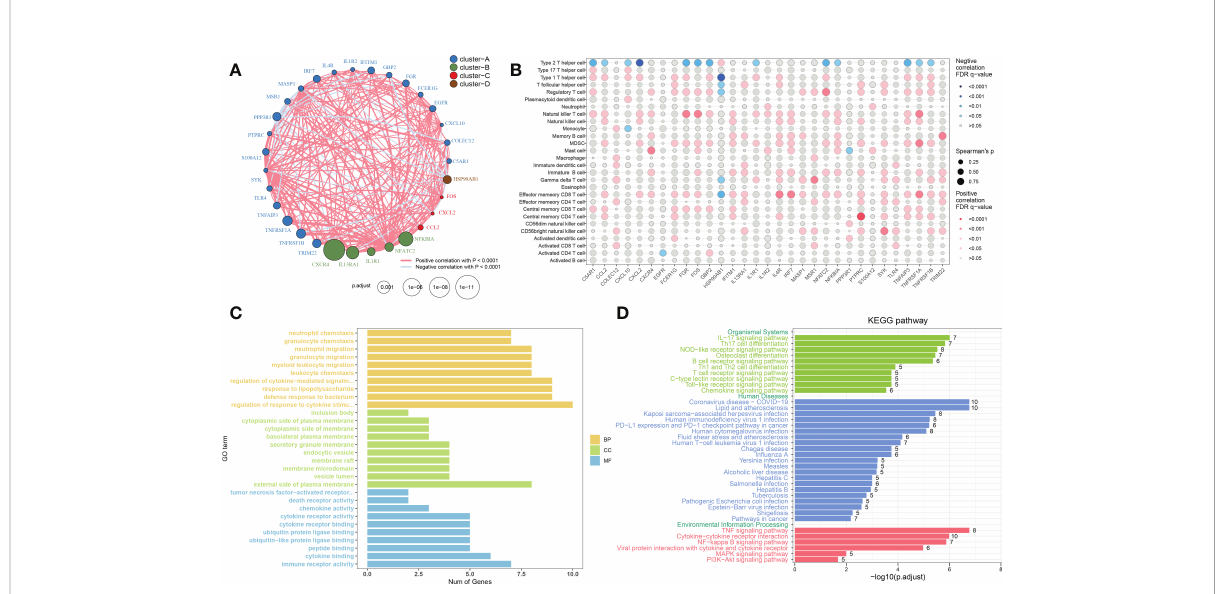
FIGURE 4 Correlation and functional enrichment analysis of immune microenvironment-related DEGs. (A) Interactions among 31 immune microenvironment-related DEGs. The circle size represented the impact of each regulator on AD, the p-value was adjusted based on the Benjamini – Hochberg method. Different colors corresponded to different gene clusters. The lines connecting the DEG represented interactions, and the thickness of the lines represented the strength of the correlation. Red color corresponded to positive correlations and blue color corresponded to negative correlations. (B) The correlation between 31 immune microenvironment-related DEGs and 28 immune cell subsets. The circle size represented the value of correlation coef fi cients. Red color corresponded to positive correlations and blue color corresponded to negative correlations. The shade of color represented the adjusted p-value. (C, D) Barplots showing the GO (C) and KEGG (D) enrichment analysis of 31 immune microenvironment-related